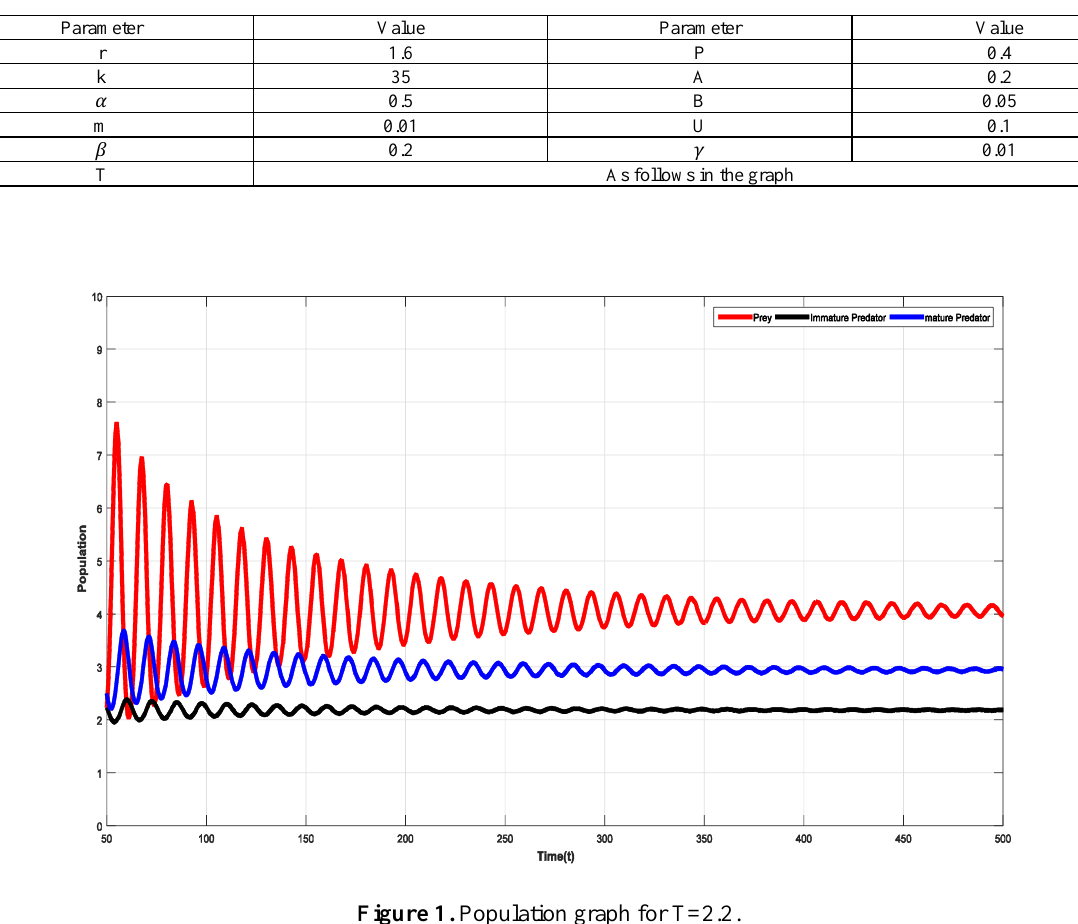
Figure 1. Population graph for